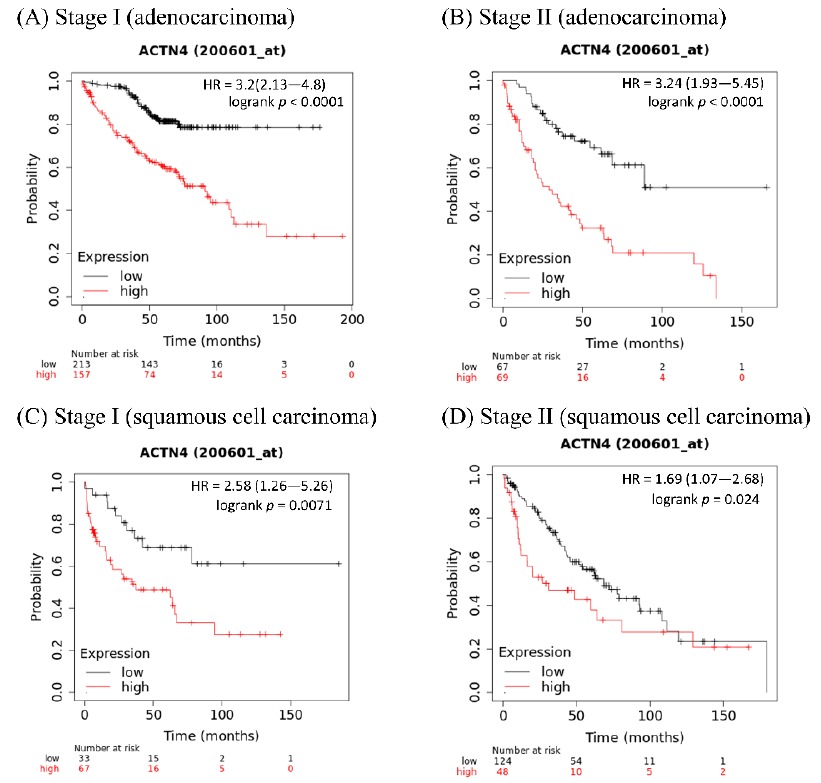
Figure 3. Kaplan–Meier curves showing overall survival in patients with lung cancer (actinin-4 expression high versus low). Overall survival in patients with ( A ) stage I lung adenocarcinoma, ( B ) stage II lung adenocarcinoma, ( C ) stage I lung squamous cell carcinoma, and ( D ) stage II lung squamous cell